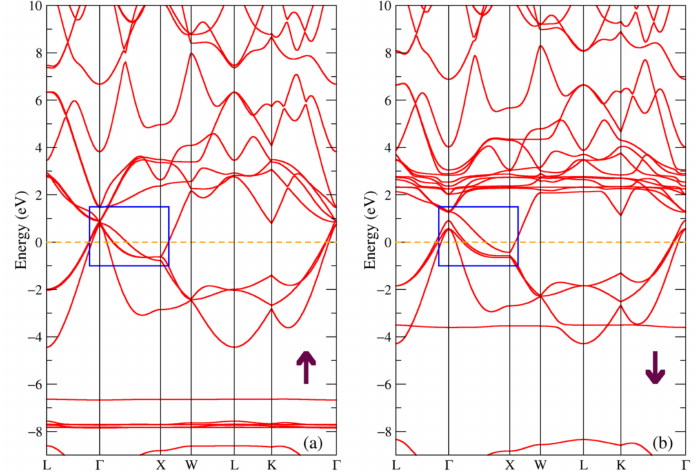
Figure 4. Band structure of TbSb: ( a ) majority and ( b ) minority spin projections. The blue rectangle points out the bands involved in the formation of pockets, see in the